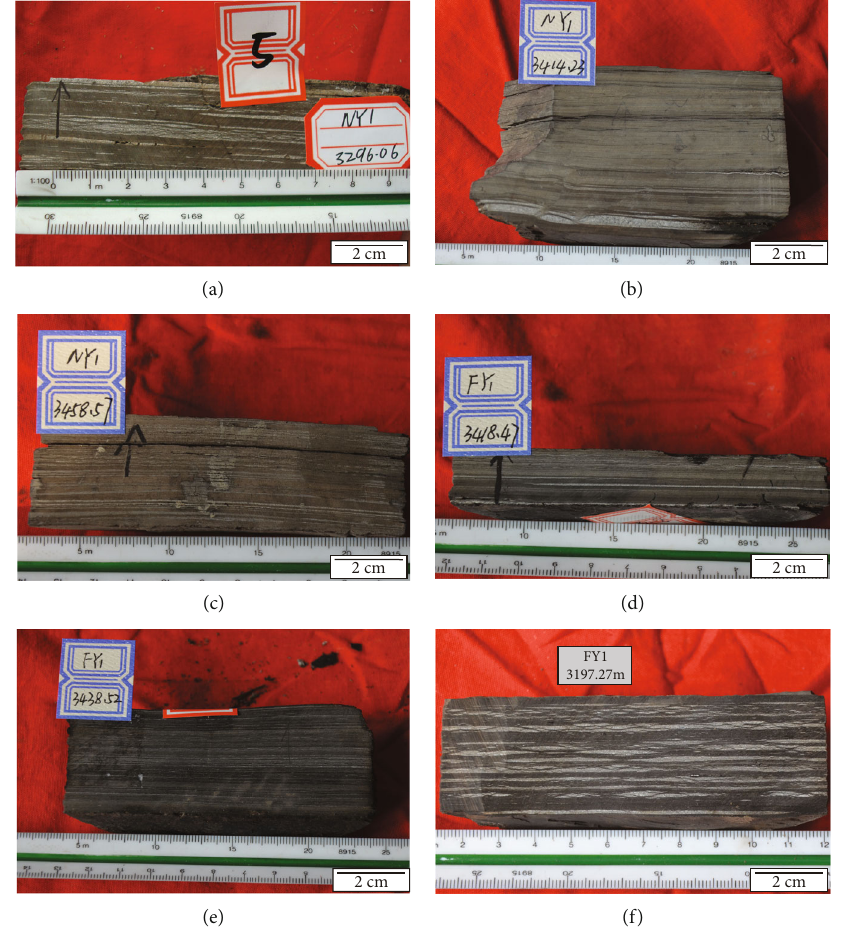
Figure 5: Features of the calcite vein as seen in the core. (a) NY1, 3296.06m: the bedding-parallel calcite vein consists of a few lenticular and lamellar calcite veins. (b) NY1, 3414.23 m: the calcite vein is approximately 5mm thick, and fractures have developed in the host rock. (c) NY1, 3458.57m: the vein is only approximately 1 mm thick, and interbedded shale consists of clay mineral laminae and calcite laminae. (d) FY1, 3418.47m: this sample is similar to the sample (c) and contains a horizontal fracture at the interface between the vein and host rock. (e) FY1, 3438.52m: the thickness of vein is less than 1 mm. (f) FY1, 3197.27m: several lenticular veins overlap to form a bedding- parallel calcite vein and solid inclusions are trapped in